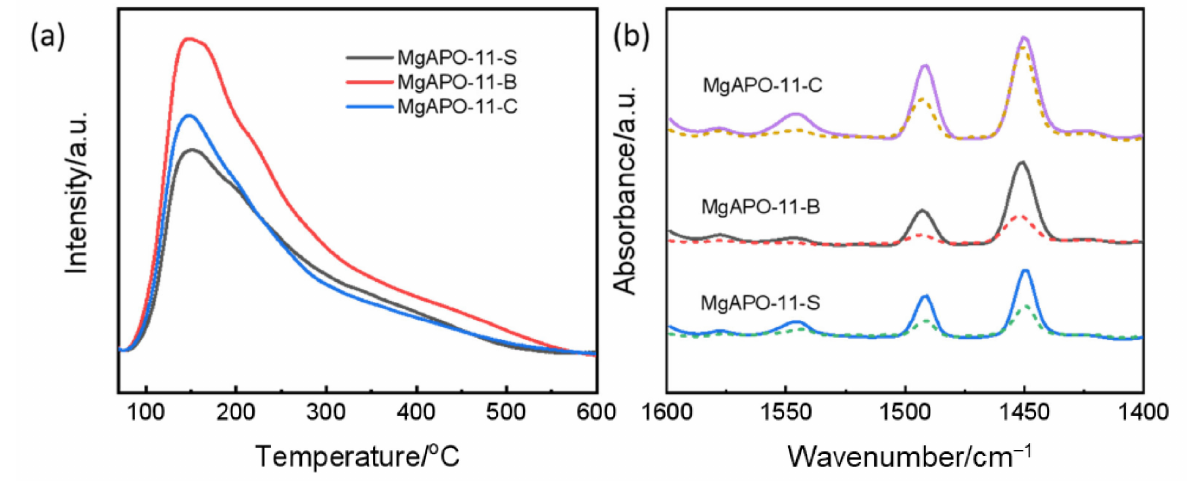
Figure 3. Characterization data of the amount and strength of acid sites in all MgAPO-11 samples: ( a ) NH 3 -TPD profiles and ( b ) Py-IR spectra of the three MgAPO-11 samples at 200 (solid line) and 350 ◦ C (dotted